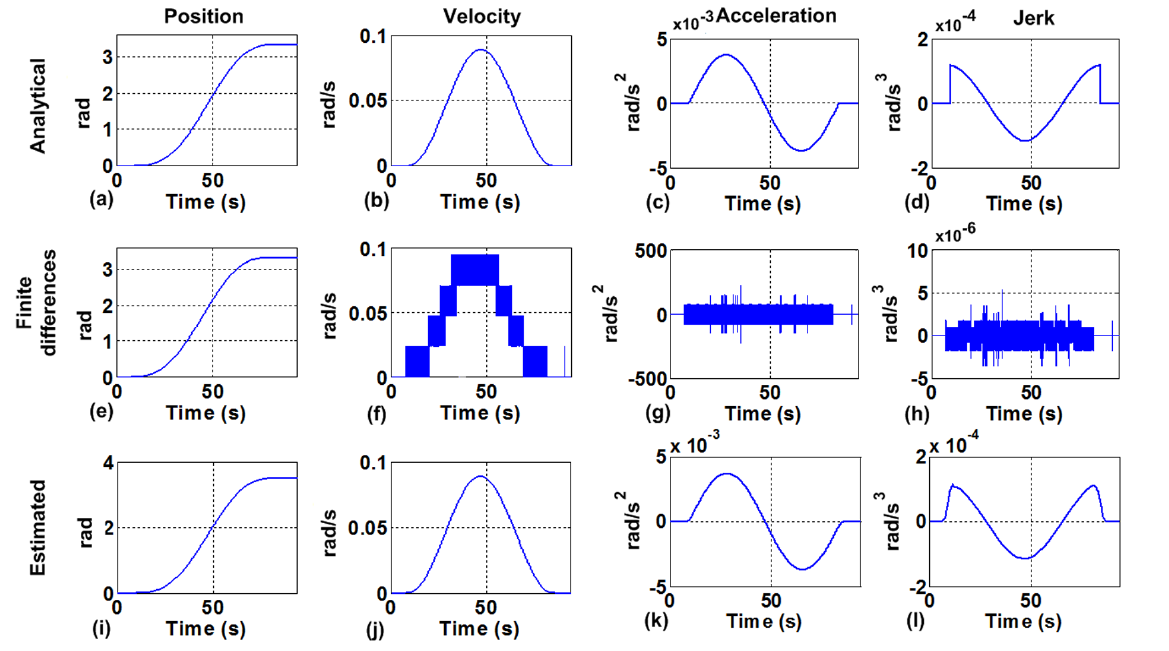
Figure 1. Analytical polynomial-motion profile: (a) position, (b) velocity, (c) acceleration, (d) jerk; recursive finite differentiation of the encoder: (e) position, (f) velocity, (g) acceleration, and (h) jerk; estimated motion profile with decimation: (i) position, (j) velocity, (k) acceleration, (l)